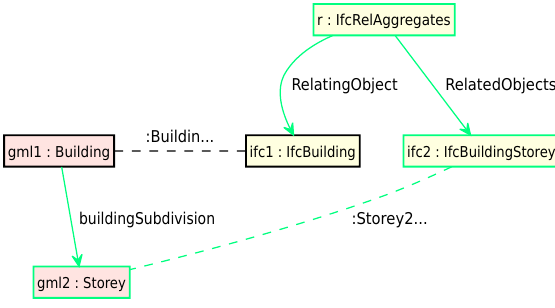
Figure 6. Concrete rule for storeys (extends aggregation, storey rule, see Figures 2 and